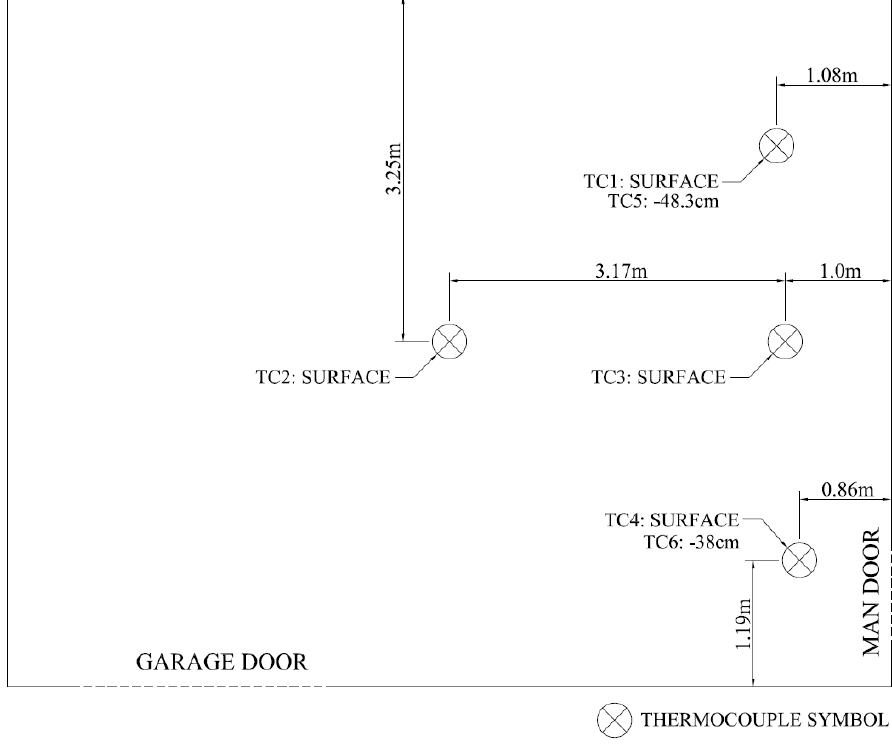
Figure 13. Temperature profile obtained for each thermal storage location.